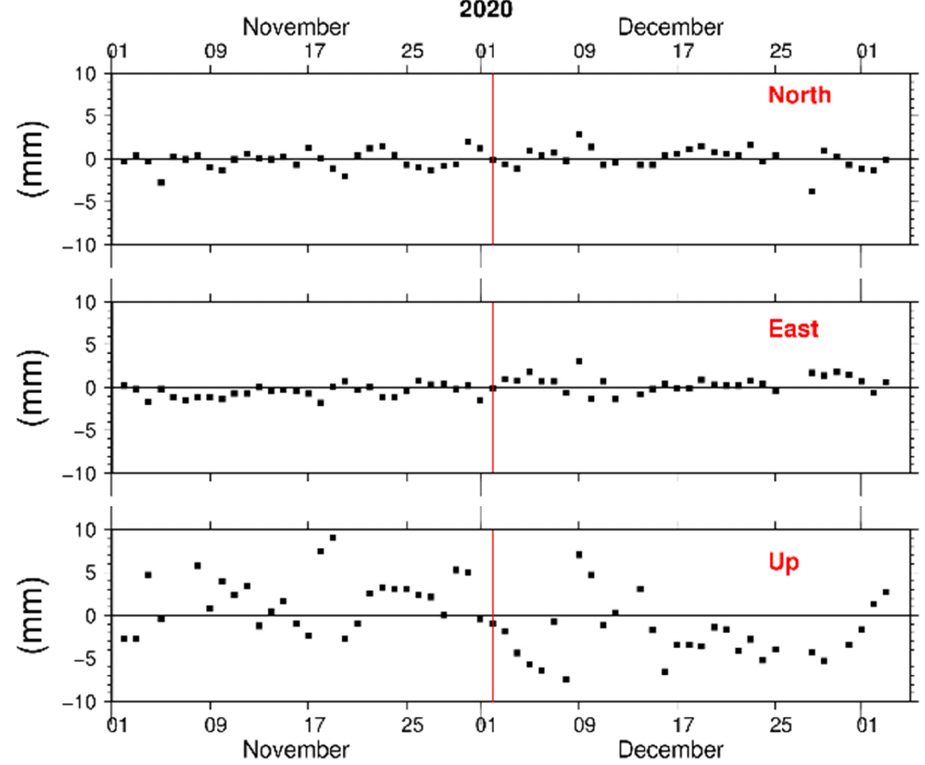
Figure A1. Time series of THIV continuous GNSS station for the north–south, east–west and vertical components. Red line marks the day of the earthquake. The reference frame is ITRF2014. Following, we adduce information concerning the quality of our InSAR processing and solutions, including the inversion-related data (Table A1 and Figures A2 and A3) and the descending model (Figure A4). Table A1. Sampled values (fringe pickings) from the ascending interferogram with track nr. 102 and the descending one track 7, both spanning the dates 21 November 2020–3 December 2020, along with their modeled values. Ascending Track 102 Descending Track 102 Pick No.